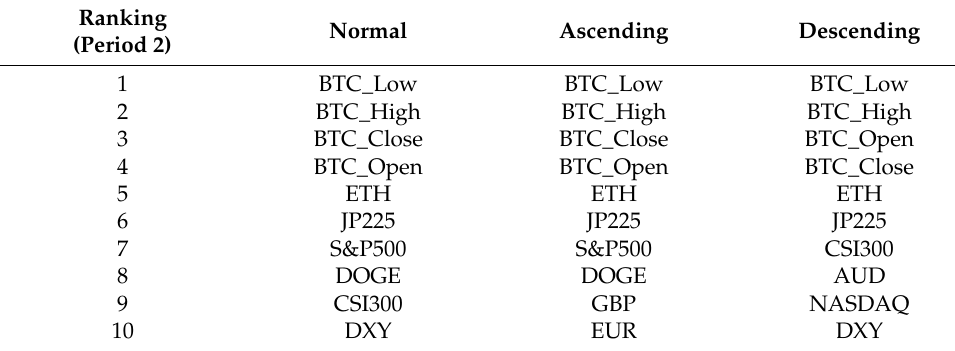
Table 6. Summary of explanatory variables importance of Period